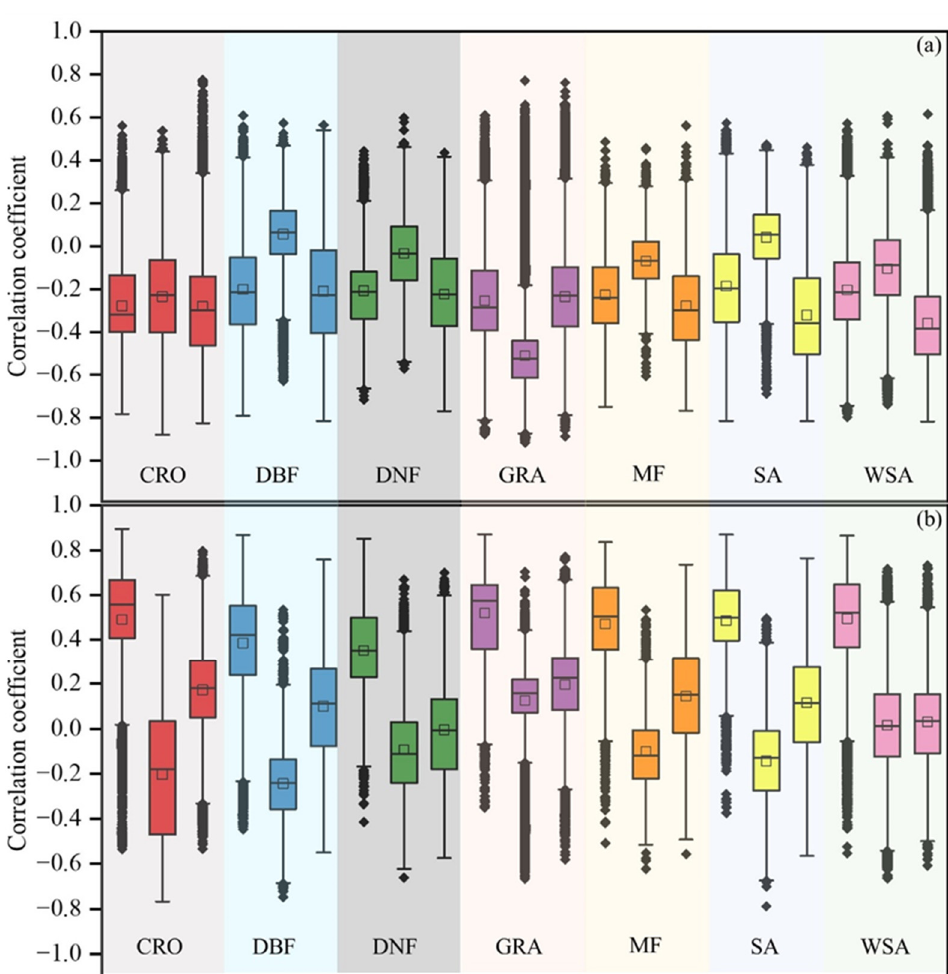
Figure 10. Correlation analysis between seasonal eWUE and climatic factors of different vegetation types. ( a ) Results of correlation analysis between seasonal eWUE and precipitation; ( b ) results of correlation analysis between seasonal eWUE and temperature.